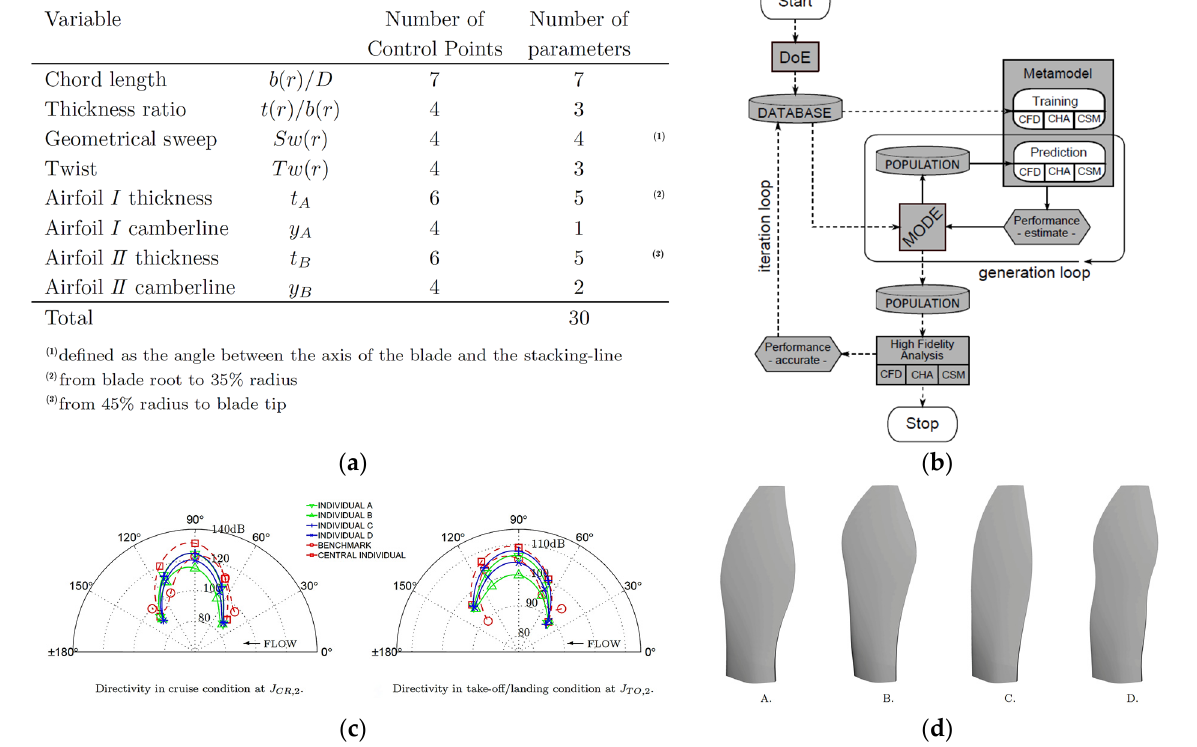
Figure 6. Optimization of blade geometry with acoustic constraint [32]. ( a ) Optimization Design Variables. ( b ) Workflow of Optimization Framework. ( c ) Noise Directivity of Optimized Blade Geometries. ( d ) Optimized Blade Geometries. Reprinted with permission from Marinus, B.G. (2011).